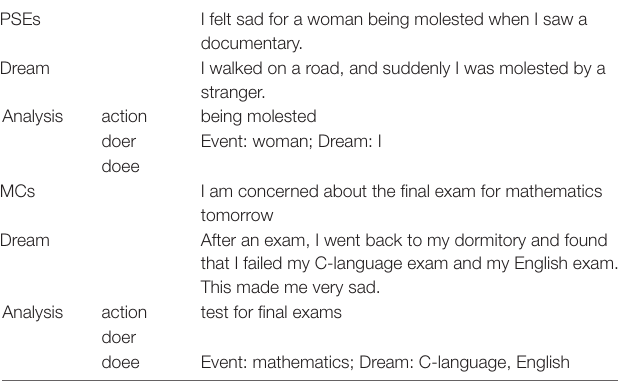
TABLE 5 | The example of metaphorical-incorporation in an events-dreams pair, for PSEs-dream pair and MCs-dream pair separately.